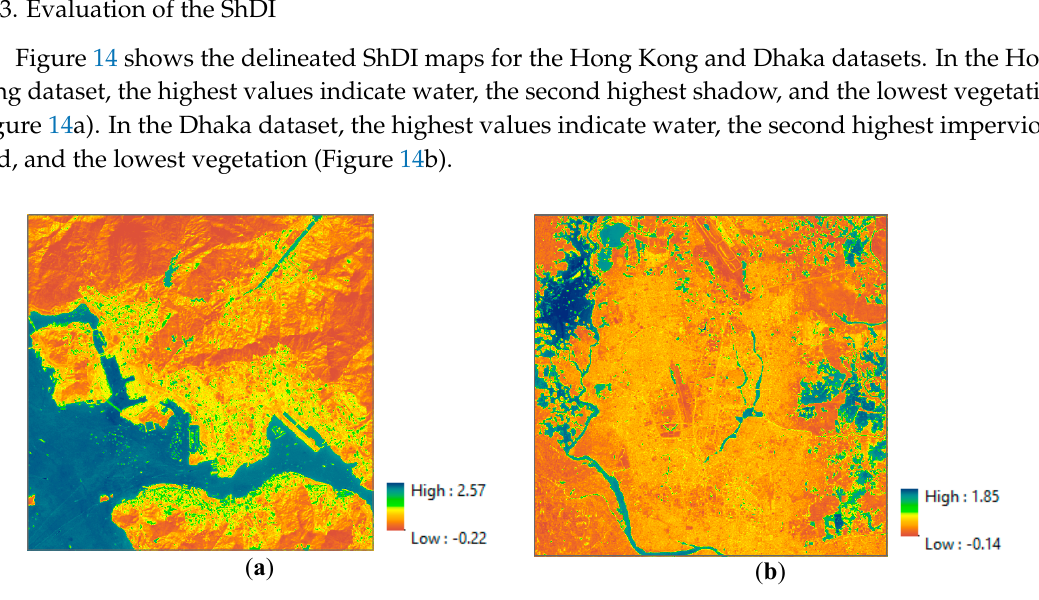
( a ) Index Reflectance. ( b ) Classification Results.